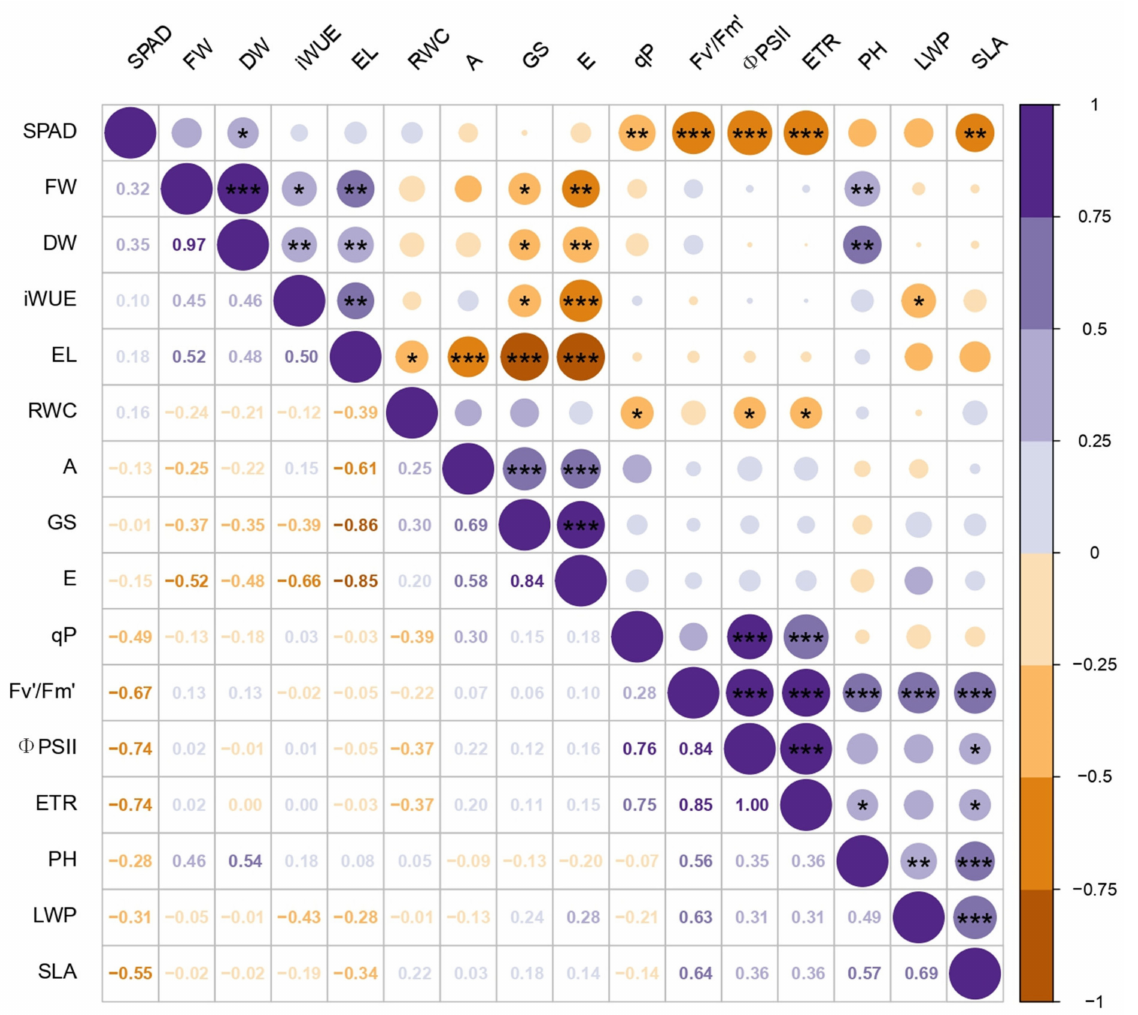
Figure 6. Pairwise Spearman’s rank correlation coefficients calculated for the surveyed traits. Above the diagonal: graphical representation, with the colours and size of the circles referring to the direction and intensity of the correlations, while the symbols *, **, *** express significant correlations at p < 0.05, 0.01, and 0.001 Below the diagonal: numerical